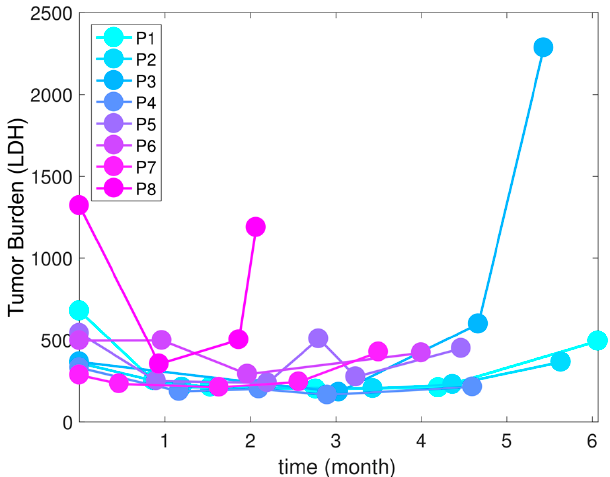
Figure 1. The tumor burdens (measured by LDH level units/liter) of eight melanoma patients in months since the beginning of therapy. All eight patients received continuous MTD of targeted therapy (BRAF and MEK inhibitor).